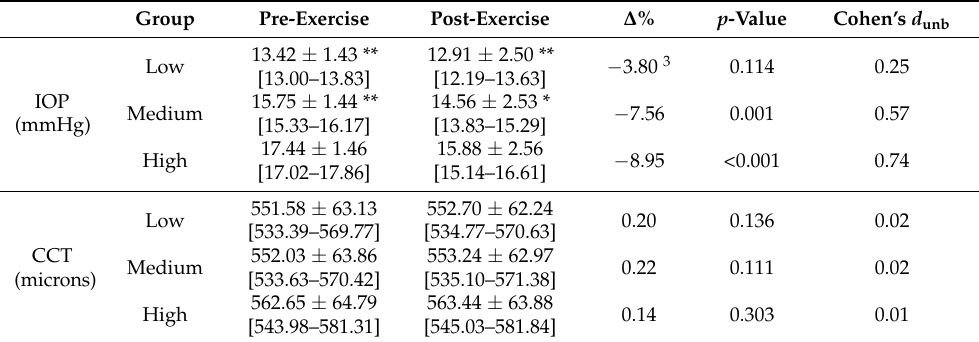
Table 5. Data comparison between the pre- and post- exercise intraocular pressure values, according to the baseline IOP of the participants (lowest [ ≤ 14.00 mmHg], n = 18; medium [14.01 to 16.99 mmHg], n = 17; highest [ ≥ 17.00 mmHg], n =